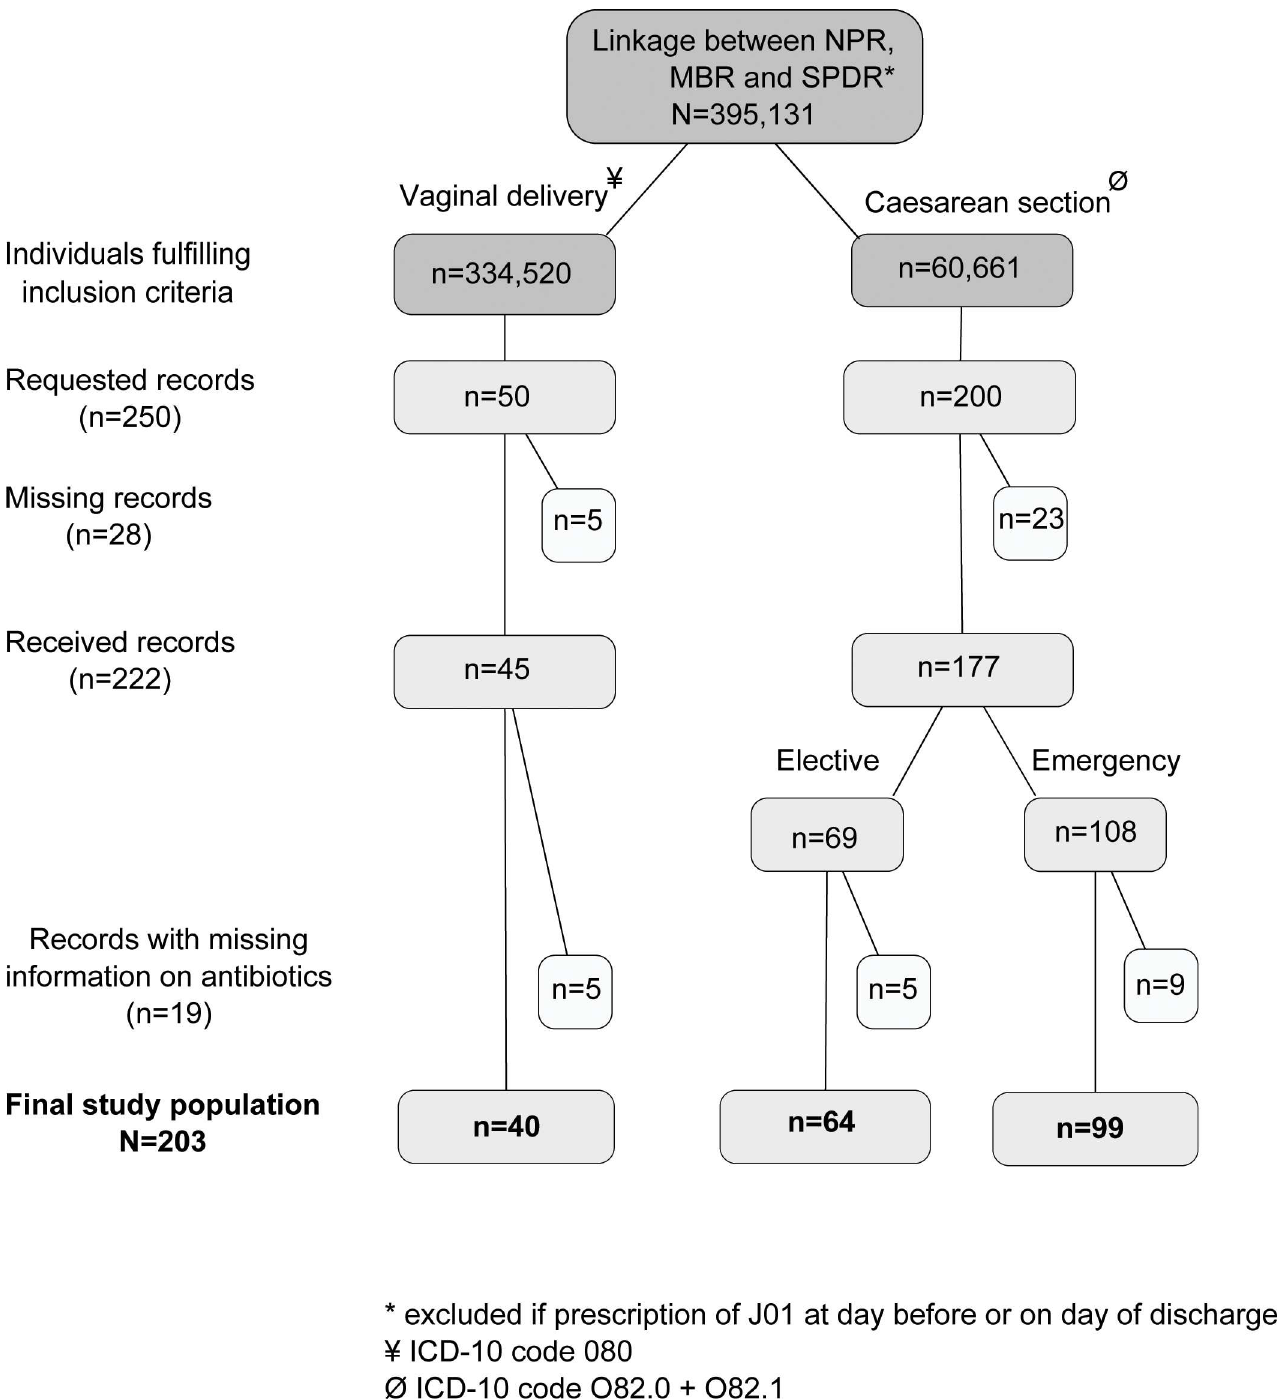
Fig 1. Study population and medical record request for pregnant women. Medical records were randomly selected from a register-based cohort of patients treated in Swedish hospitalsbetween July 2005 and November2011. Abbreviations: NPR = NationalPatient Register, MBR = Medical Birth Register, SPDR = Swedish Prescribed Drug Register, ICD-10 = International Classification of Disease 10 th revision.